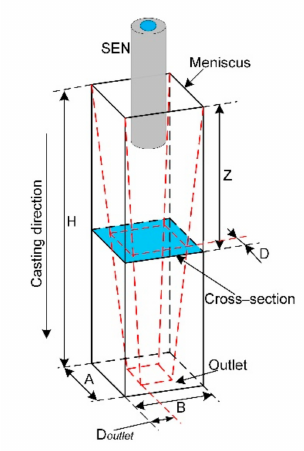
Figure 2. The sketch diagram of selecting a cross section at the casting